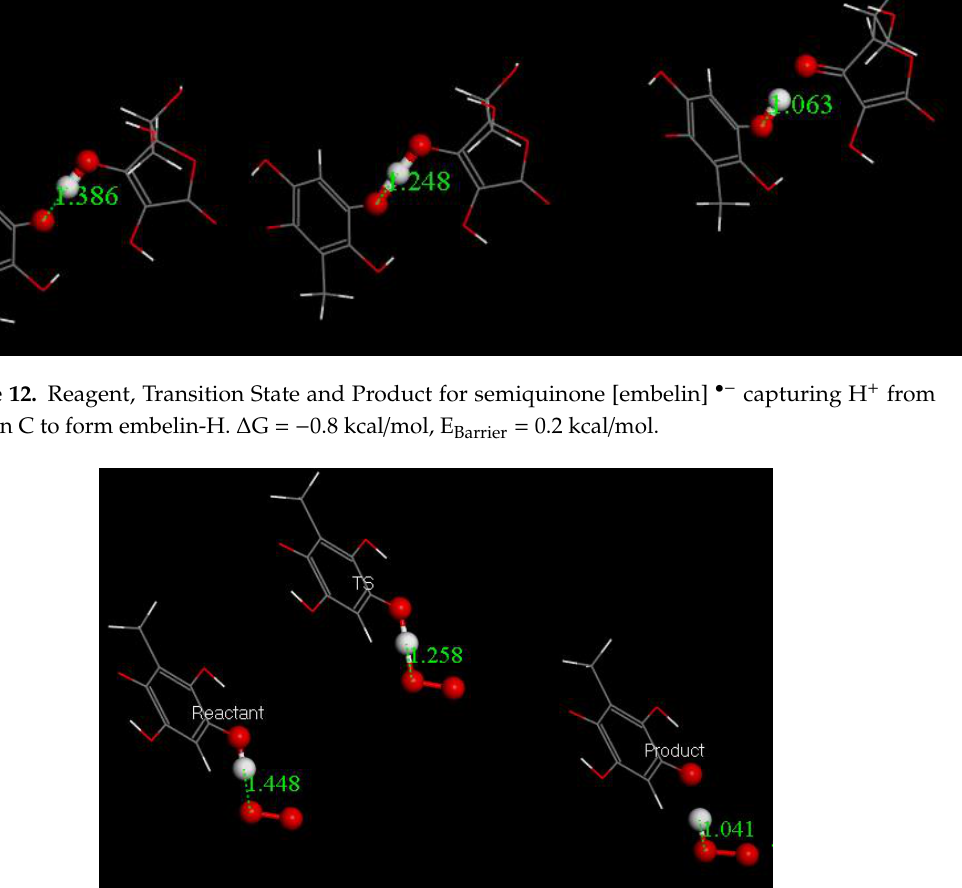
Figure 13. Reactant, Transition state and Product of embelin derivative (2,4,5-benzenetriol, 3-methyl). The scavenger donates H to O 2•− forming an aromatic radical and releasing HO 2− , which in turn will become H 2 O 2 , after capturing a proton. ΔG = −1.2 kcal/mol and E Barrier = 0.3 kcal/mol. Additional info provided in Figure